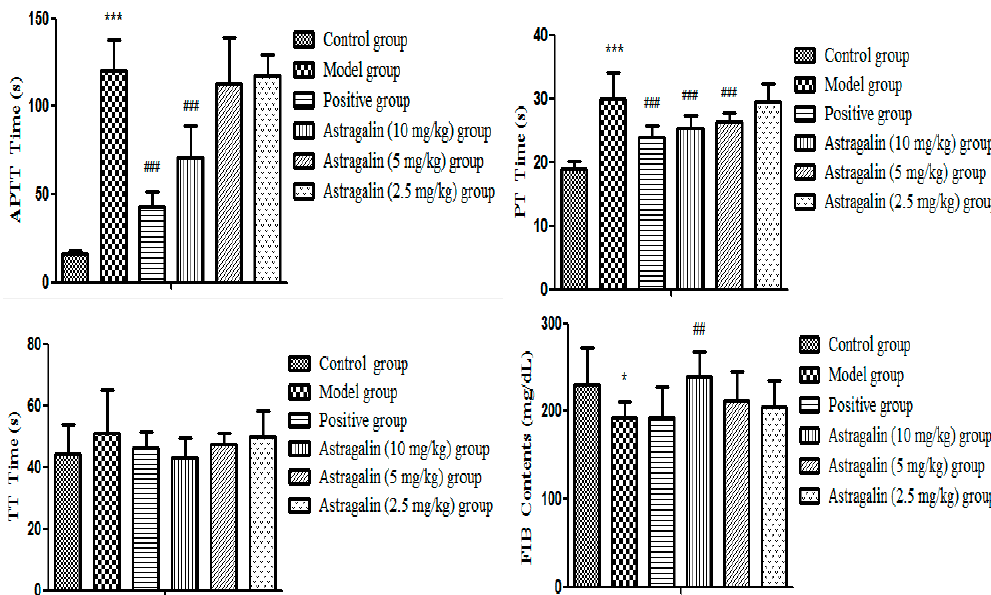
Figure 5. E ff ect of astragalin plasma coagulation parameters in vivo (X ± SD, n = 8). Compared with